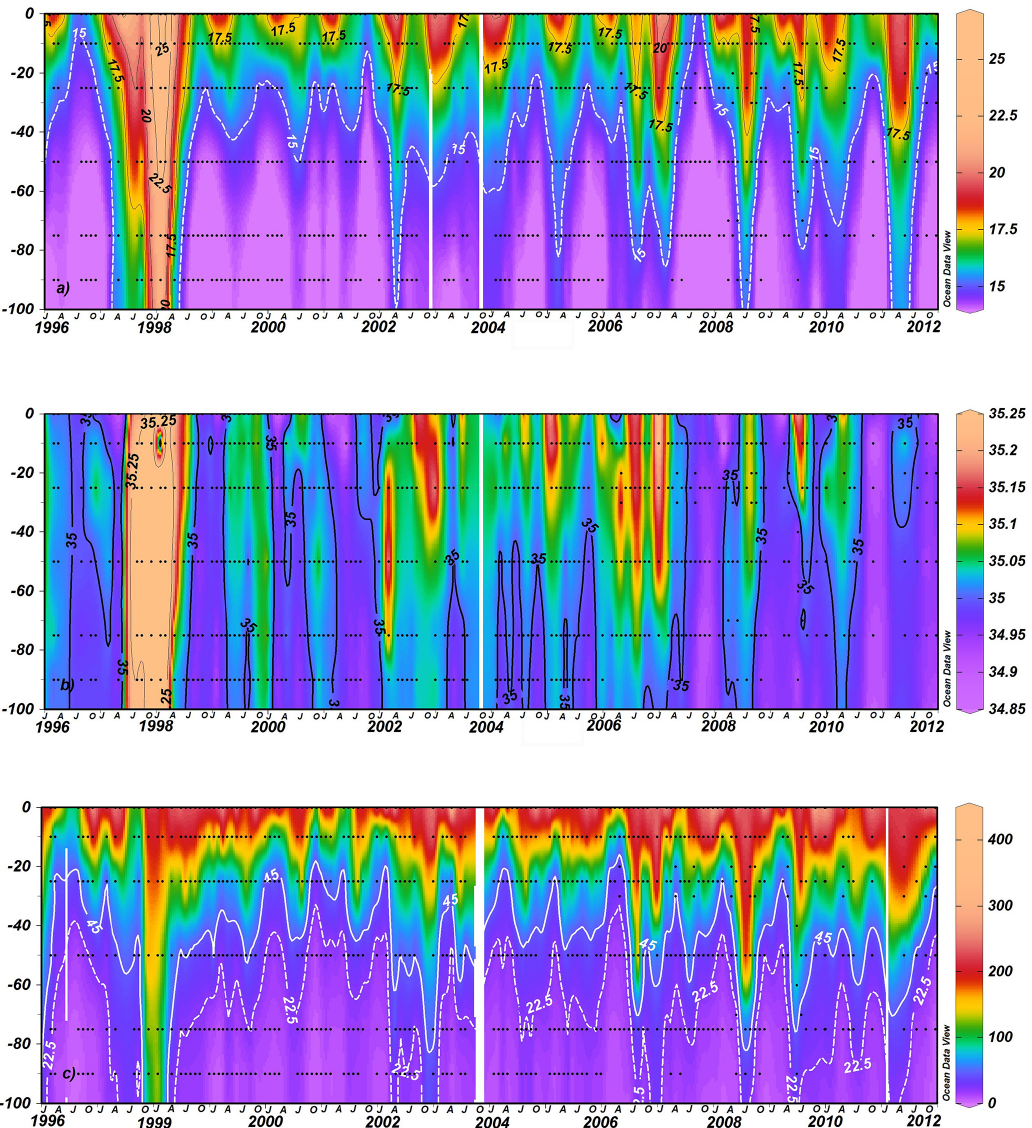
Figure 2. Time series of temperature ( ◦ C) (a) , salinity (b) and dissolved oxygen (µmolkg − 1 ) (c) during the 1996–2011 study years. Black dots indicate the location in space and time of the data, and a DIVA 2017 graphic interpolation was used for the visualization of the